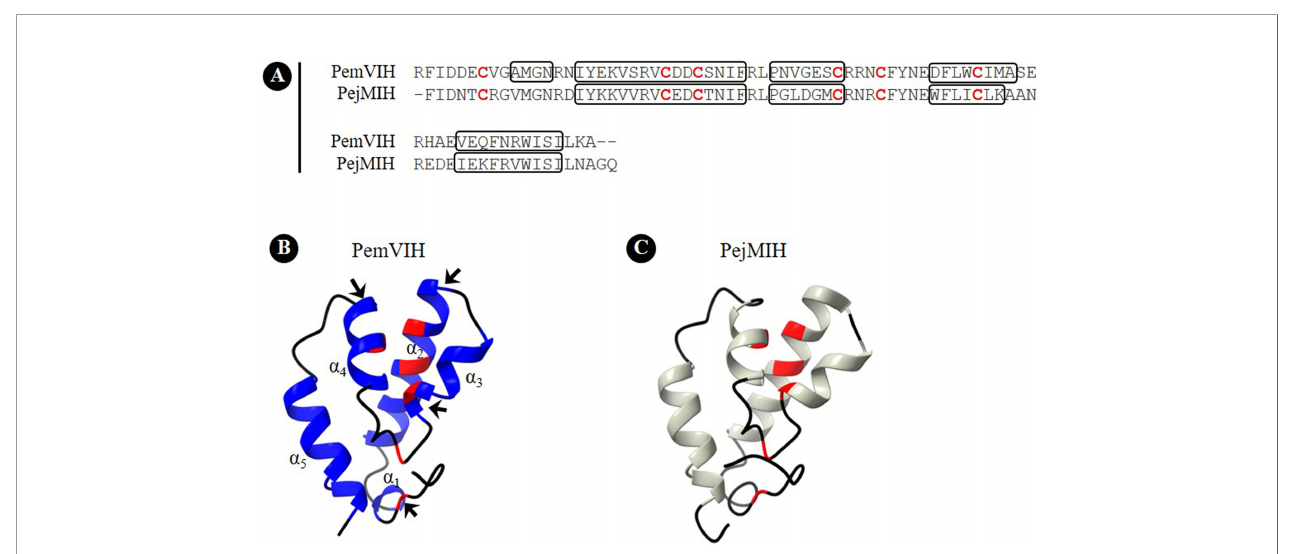
FIGURE 3 | Putative three-dimensional structure of PemVIH. (A) Amino acid sequence alignment of PemVIH and PejMIH. Conserved cysteine residues are shown in red alphabet. Boxed area indicates loop structure. Putative three-dimensional structure of (B) PemVIH and (C) PejMIH consist of 5 and 4 a -helices, respectively. The conserved six cysteine residues are labelled in red. Structural differences between PemVIH and PejMIH are indicated by the arrows in (B) .